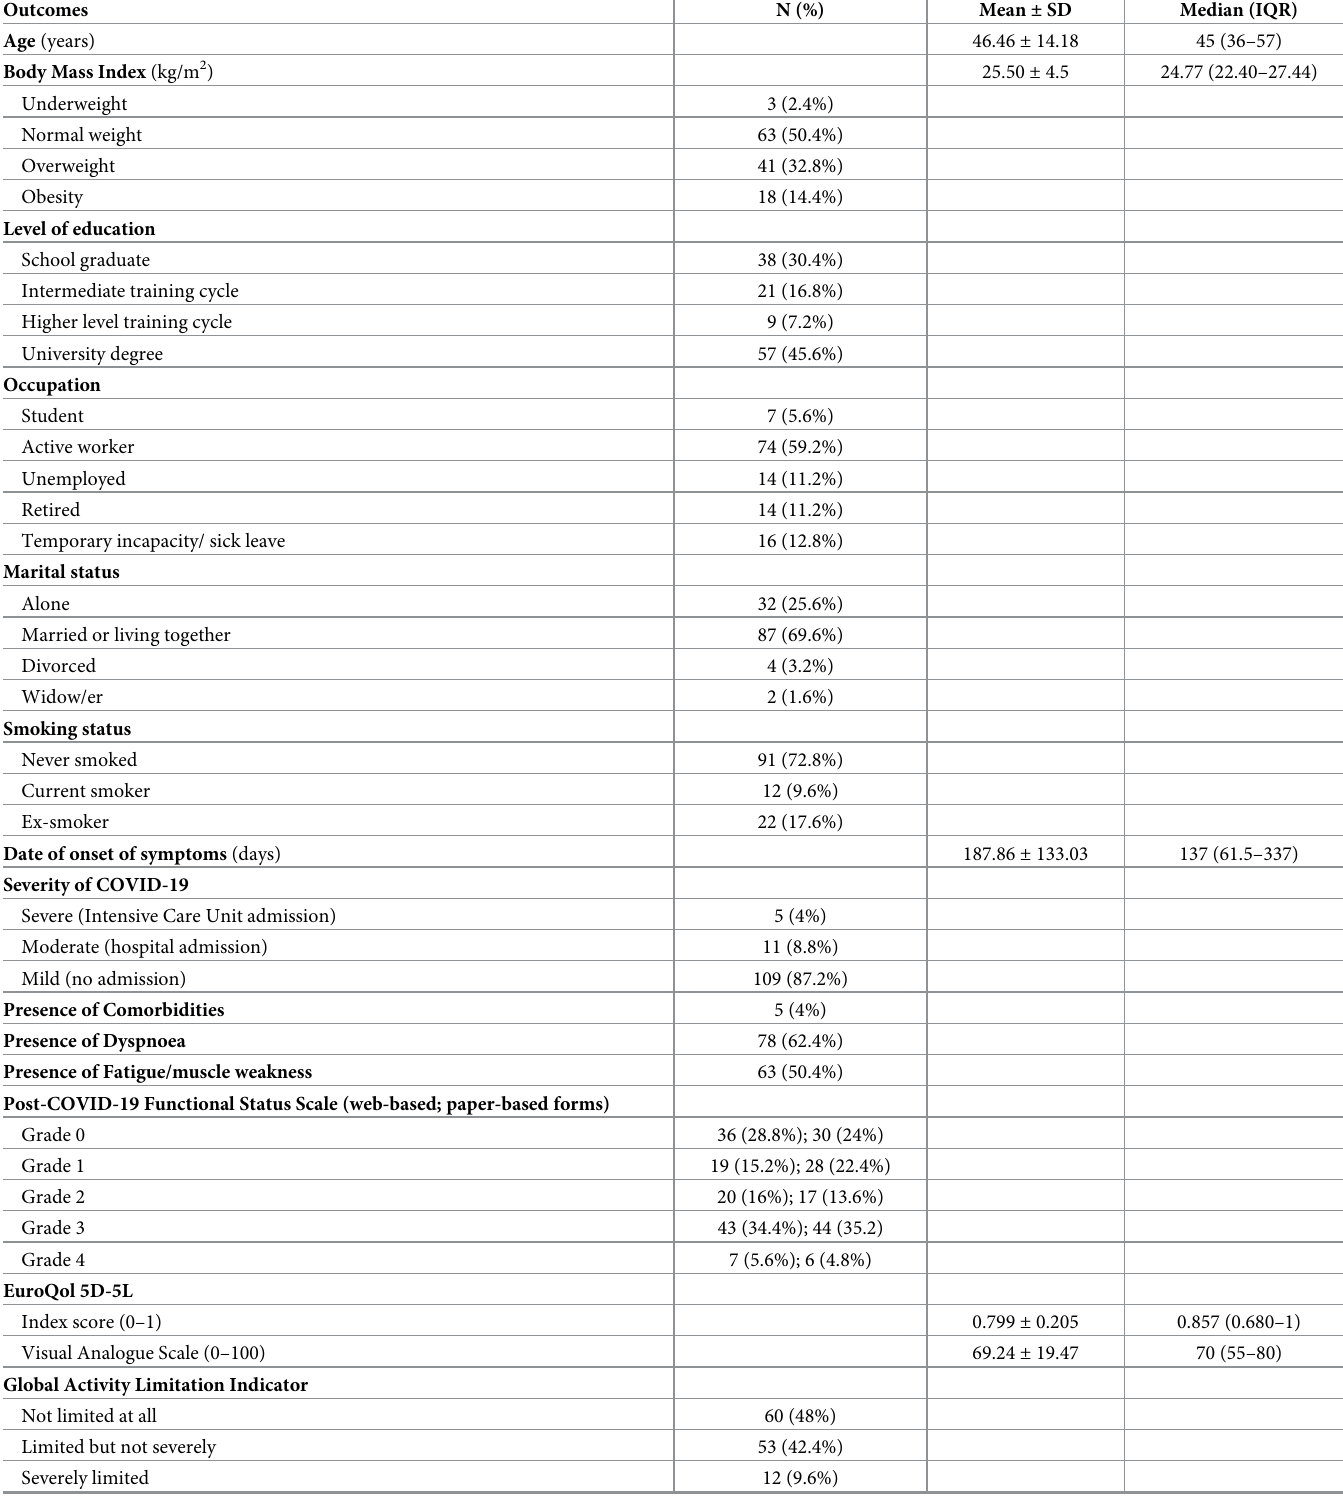
Table 1. Sociodemographic and clinical characteristics of the